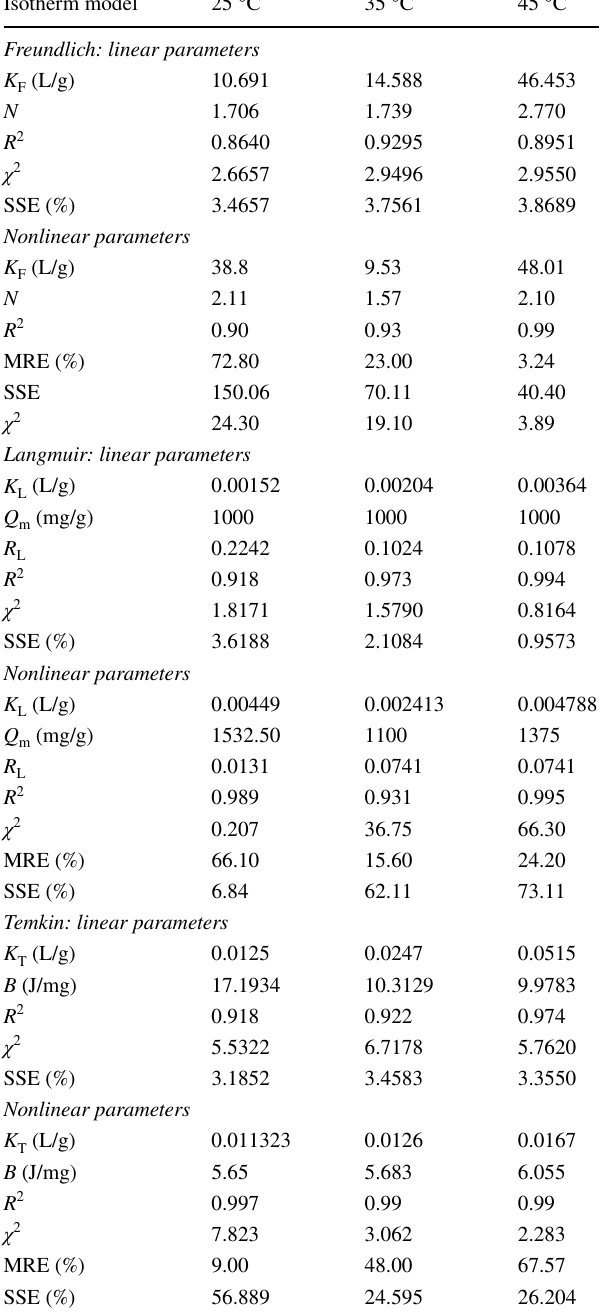
Table 6 Calculated isotherm parameters at varying temperatures Isotherm model